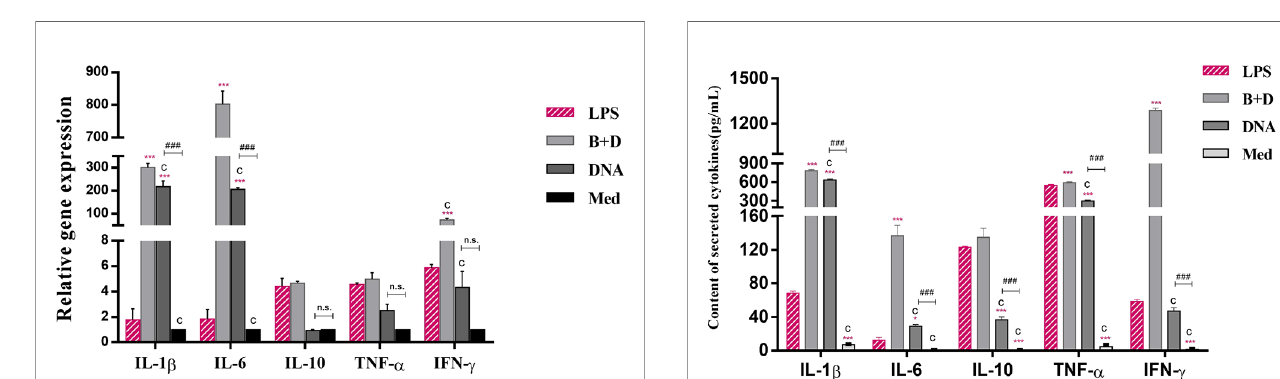
FIGURE 8 | Secretion of IL – 1 b , IL – 6, IL – 10, TNF – a and IFN – g levels in dendritic cells (DCs). DCs were incubated with pCI – PoRV – VP6 plasmid DNA (1 mg/mL) and bacterial ghosts (BGs) loaded with pCI – PoRV – VP6 plasmid DNA (1000 bacteria/cell) at 37°C for 24 h. Cytokine contents by DCs were analyzed using ELISA. Values are expressed as the mean ± SD of four individual experiments. Signi fi cance of differences between the LPS, BG +DNA, DNA, and Med groups is represented as follows: *P < 0.05, **P < 0.01, ***P < 0.001. Letter indicates signi fi cant differences between BG +DNA groups, DNA and Med groups: a P < 0.05, b P < 0.01, c P < 0.001. #Asterisk indicate signi fi cant difference between DNA and Med groups: # P < 0.05, ## P < 0.01, ### P <